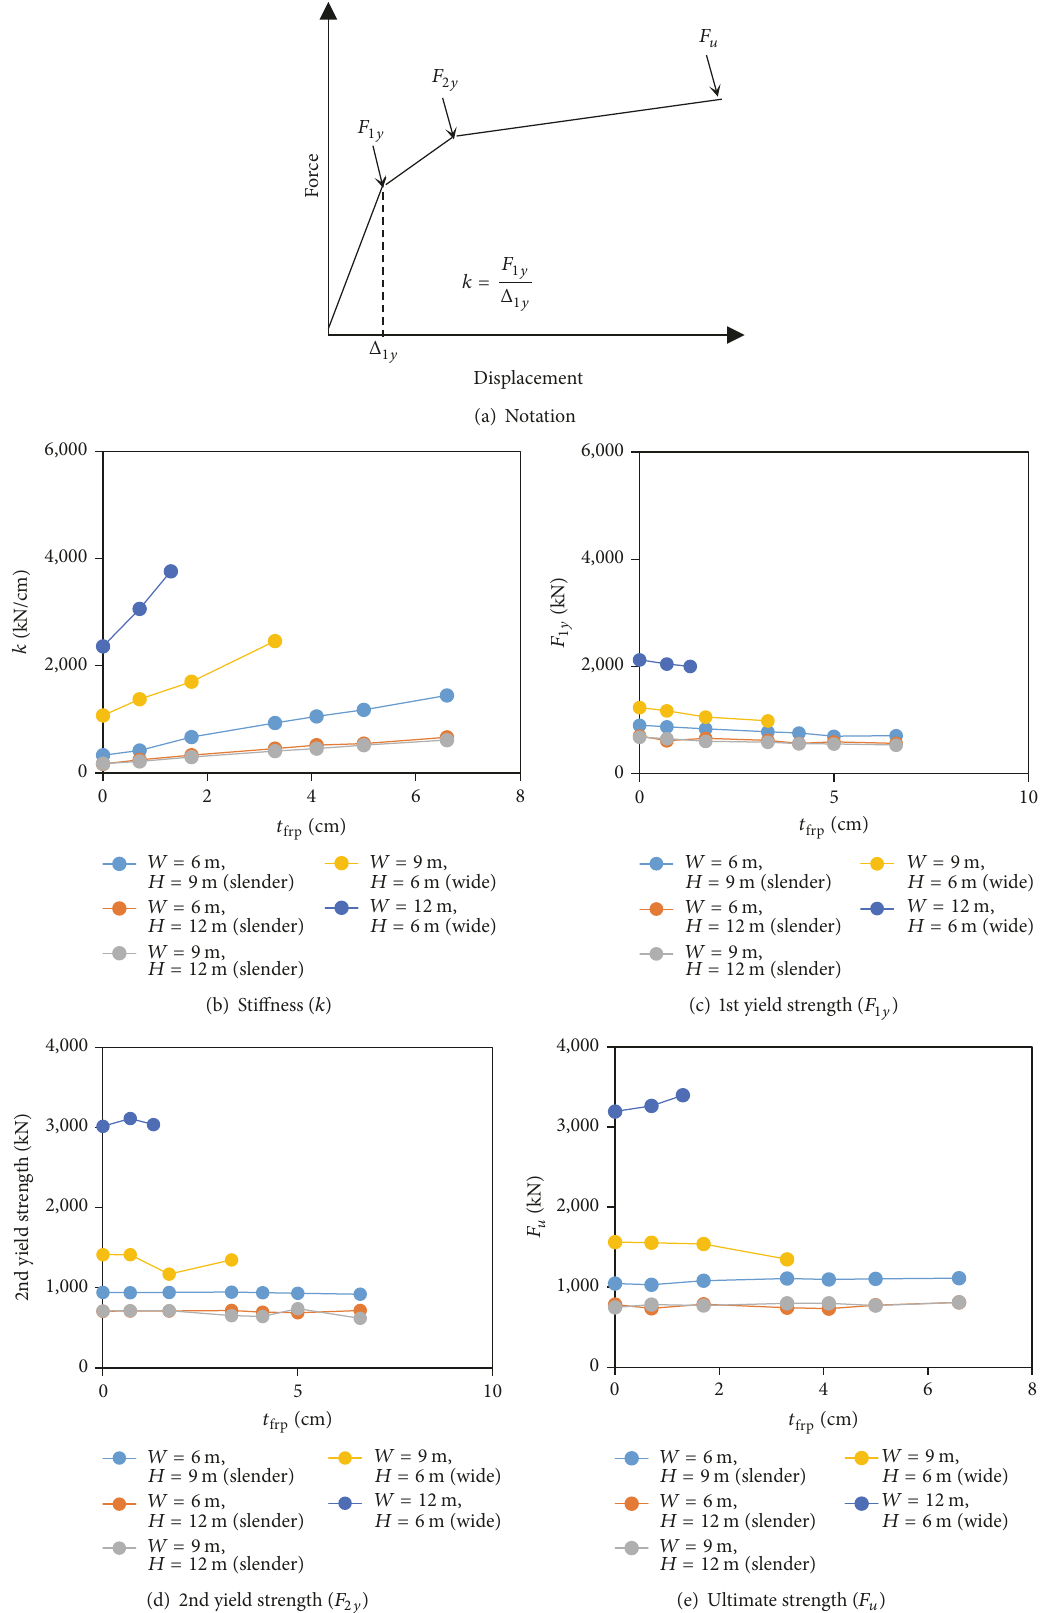
Figure 13: Effects of FRP thicknesses for various geometries of pier systems (pier section = 0.9 m by 0.9 m, 𝑡 frp = thickness of FRP